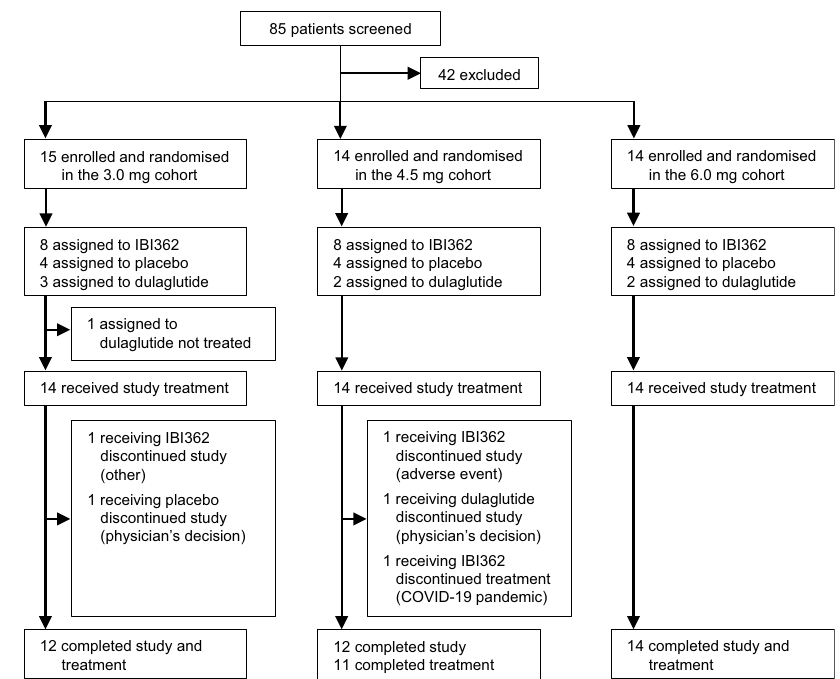
Fig. 1 Patient fl ow. The fl ow diagram shows the disposition of patients with type 2 diabetes screened and